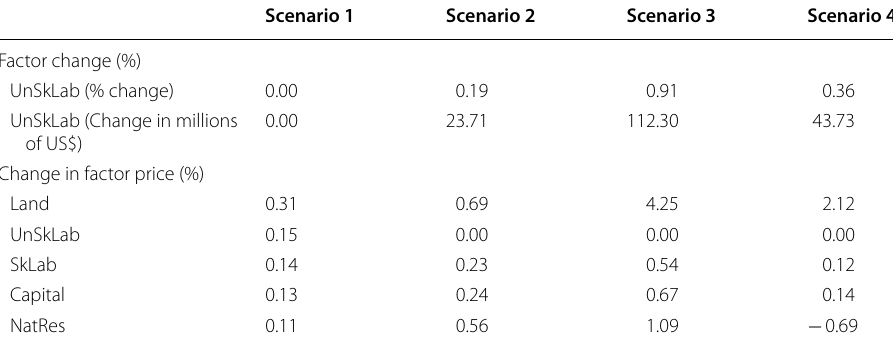
Table 8 Change in factors and factor prices (percentage). Source: Model